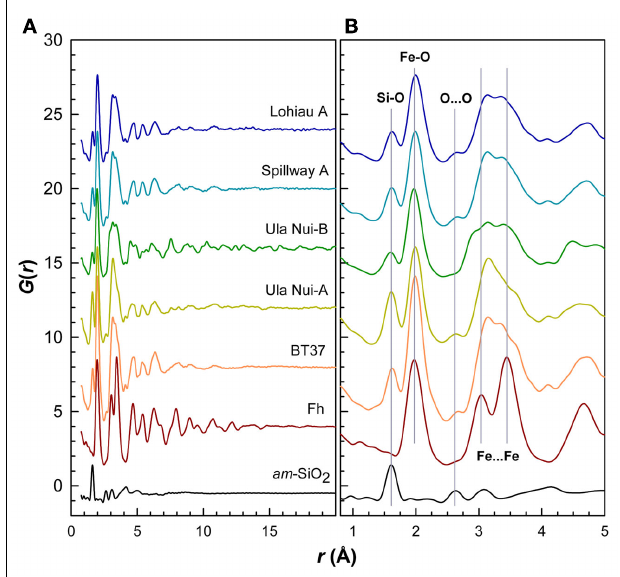
FIGURE 5 | Real-space PDFs or G ( r ) for the five natural samples compared to experimental PDFs for Fh and amorphous SiO 2 references. (A) The strong attenuation in the features of the PDFs with increasing r for the natural samples indicates smaller coherent scattering domain (CSD) sizes and increased disorder relative to synthetic Fh. Sample Ula Nui-B shows more structure at higher r due to birnessite phase impurity. (B) Comparison of the short-range order for these samples. Similarities between natural samples and synthetic references for Fh and amorphous silica are